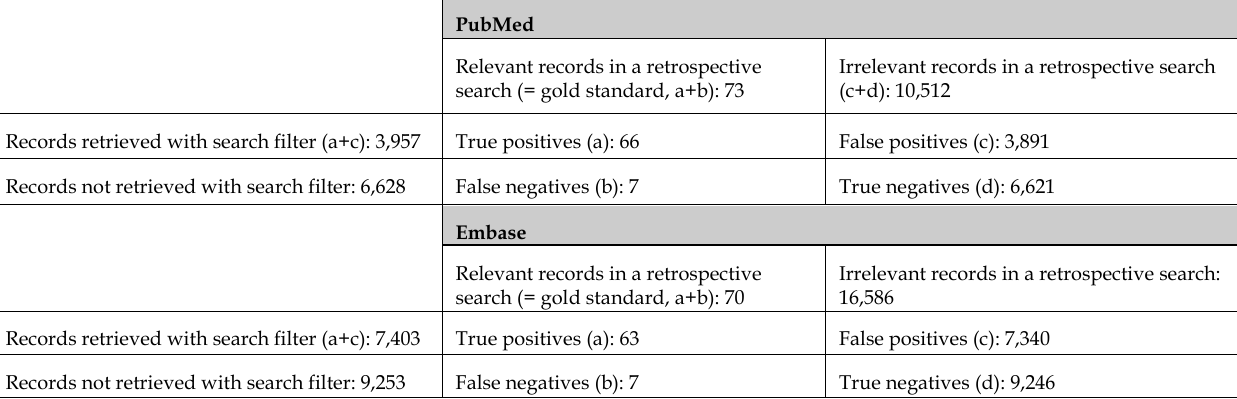
Table 4 Overview of the original intervention study search filter’s performance in PubMed and Embase in the validation reference gold standard